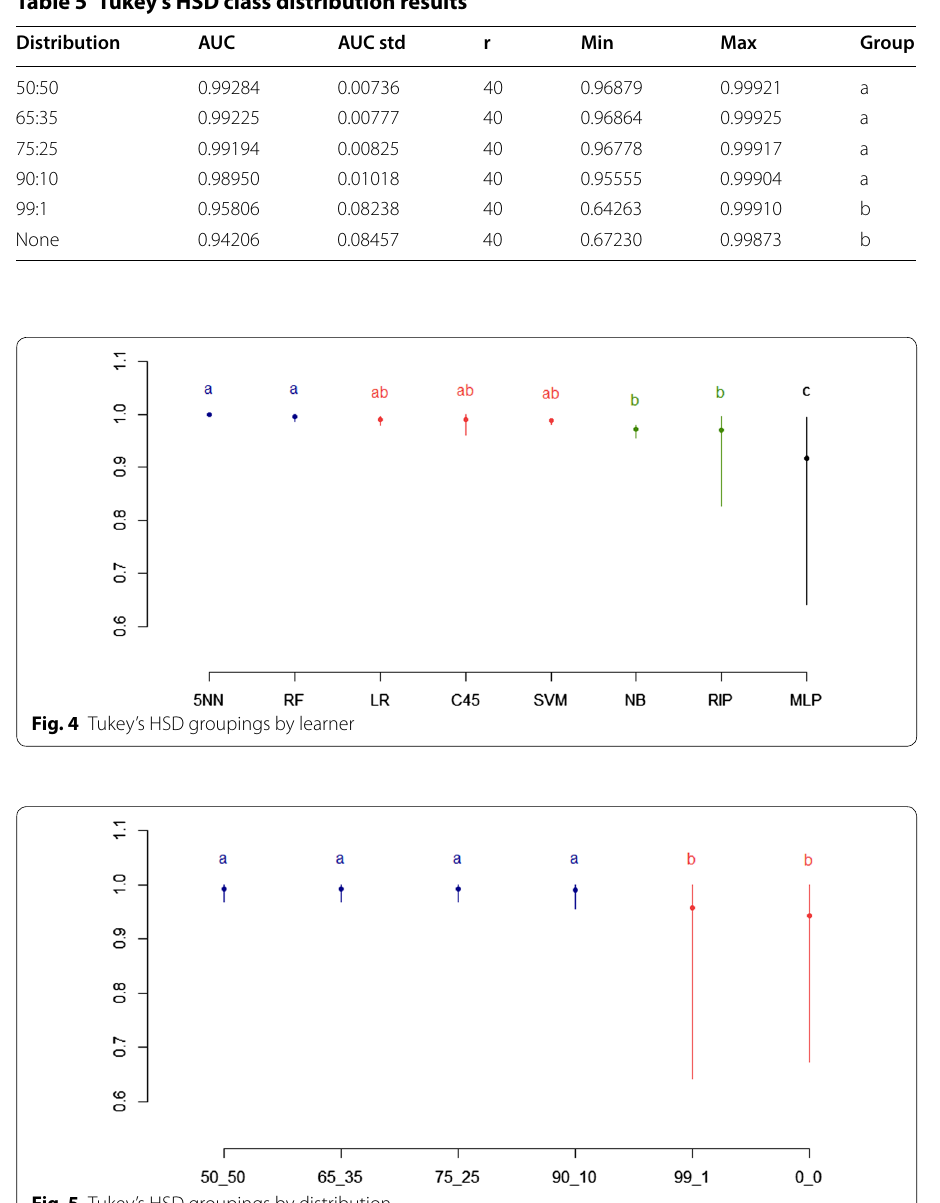
Fig. 5 Tukey’s HSD groupings by